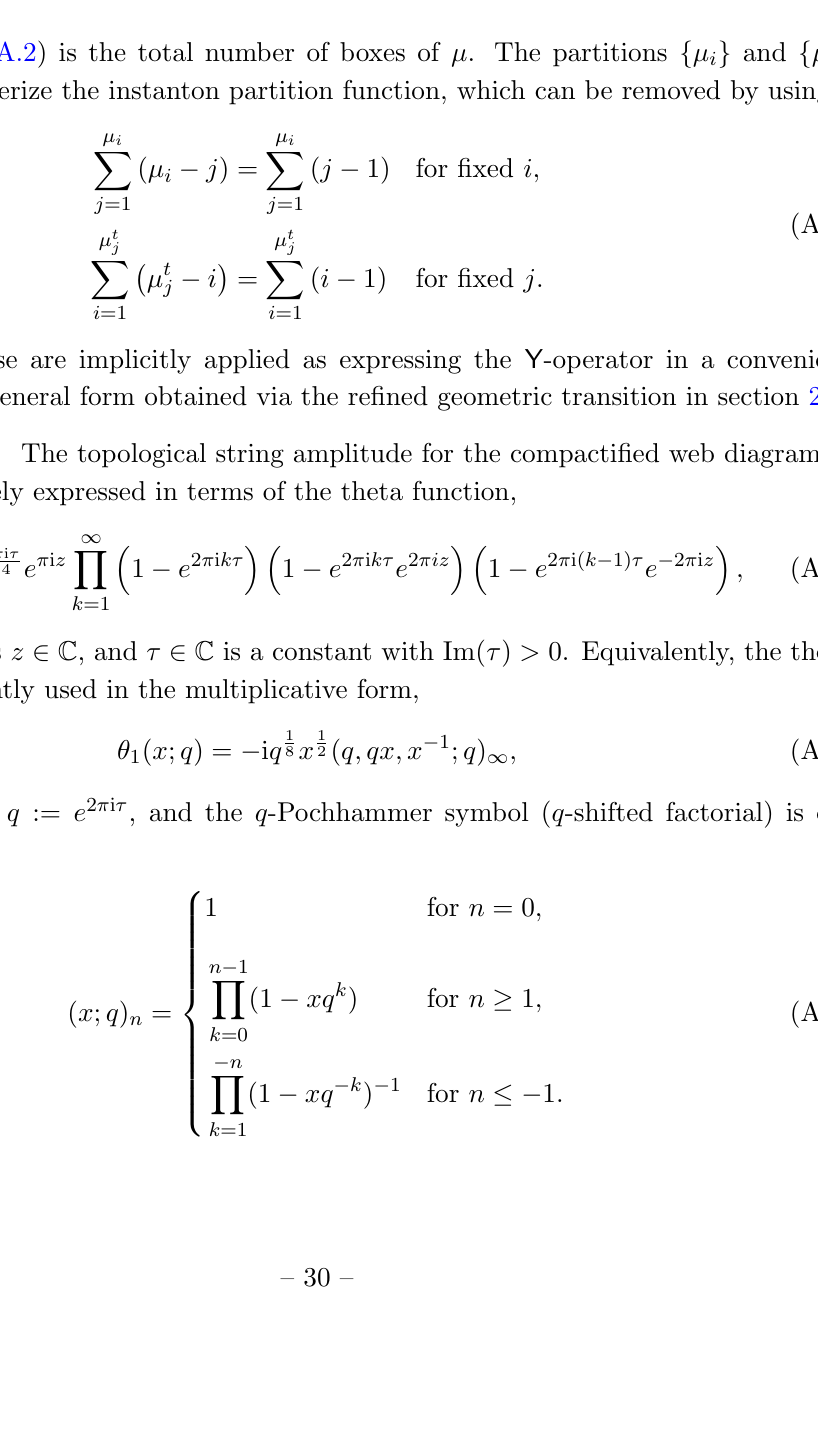
Figure 11 . The Young diagram and its